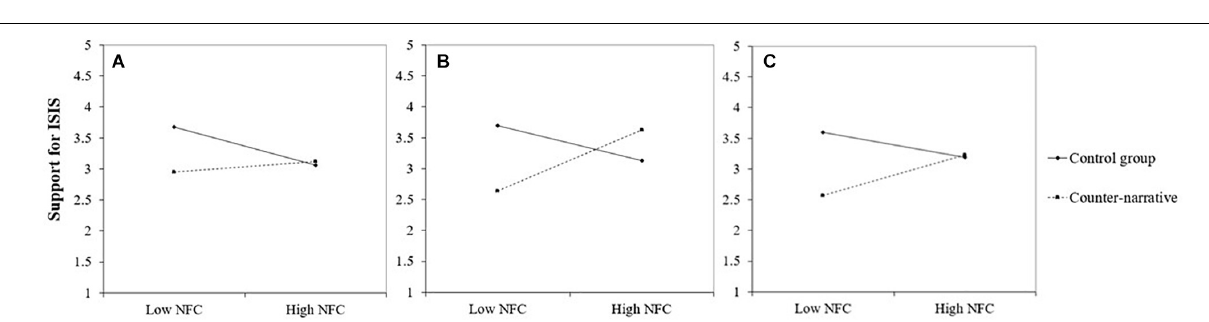
FIGURE 2 | Support for ISIS as a function of Muslims’ need for closure and exposure to a religious counter-narrative (vs. control message) delivered by (A) the United States Government, (B) an ISIS defector, and (C) an Imam. All interactions are significant. Low NFC = − 1 SD; High NFC = + 1 SD.